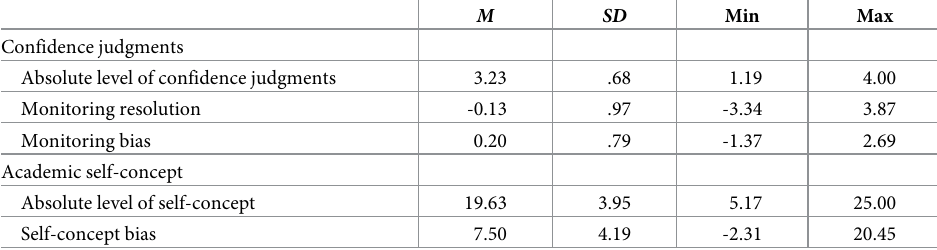
Table 1. Descriptive